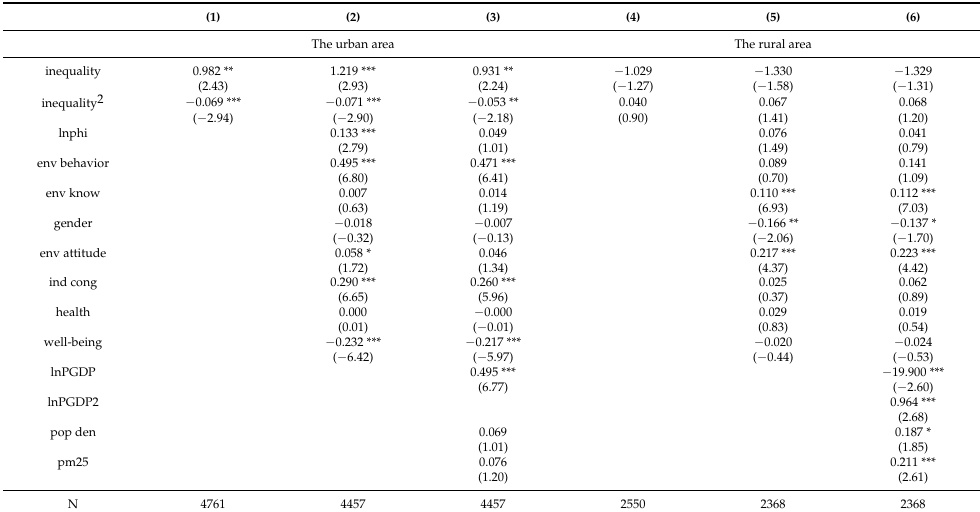
Table A9. The effect of individual-level income inequality on subjective environmental pollution: differences in urban and rural area.